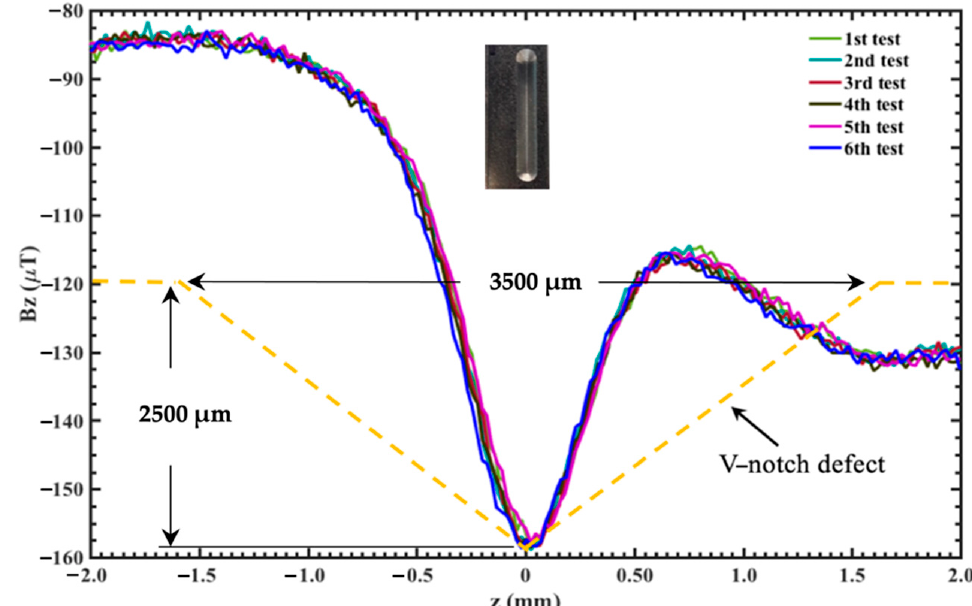
Figure 11. Variation of tangential MMM signals measured around the fifth V-shaped notch (3500 µm width and 2500 µm depth) of the ASTM-A36 steel pipe, which were measured using six experimental tests.